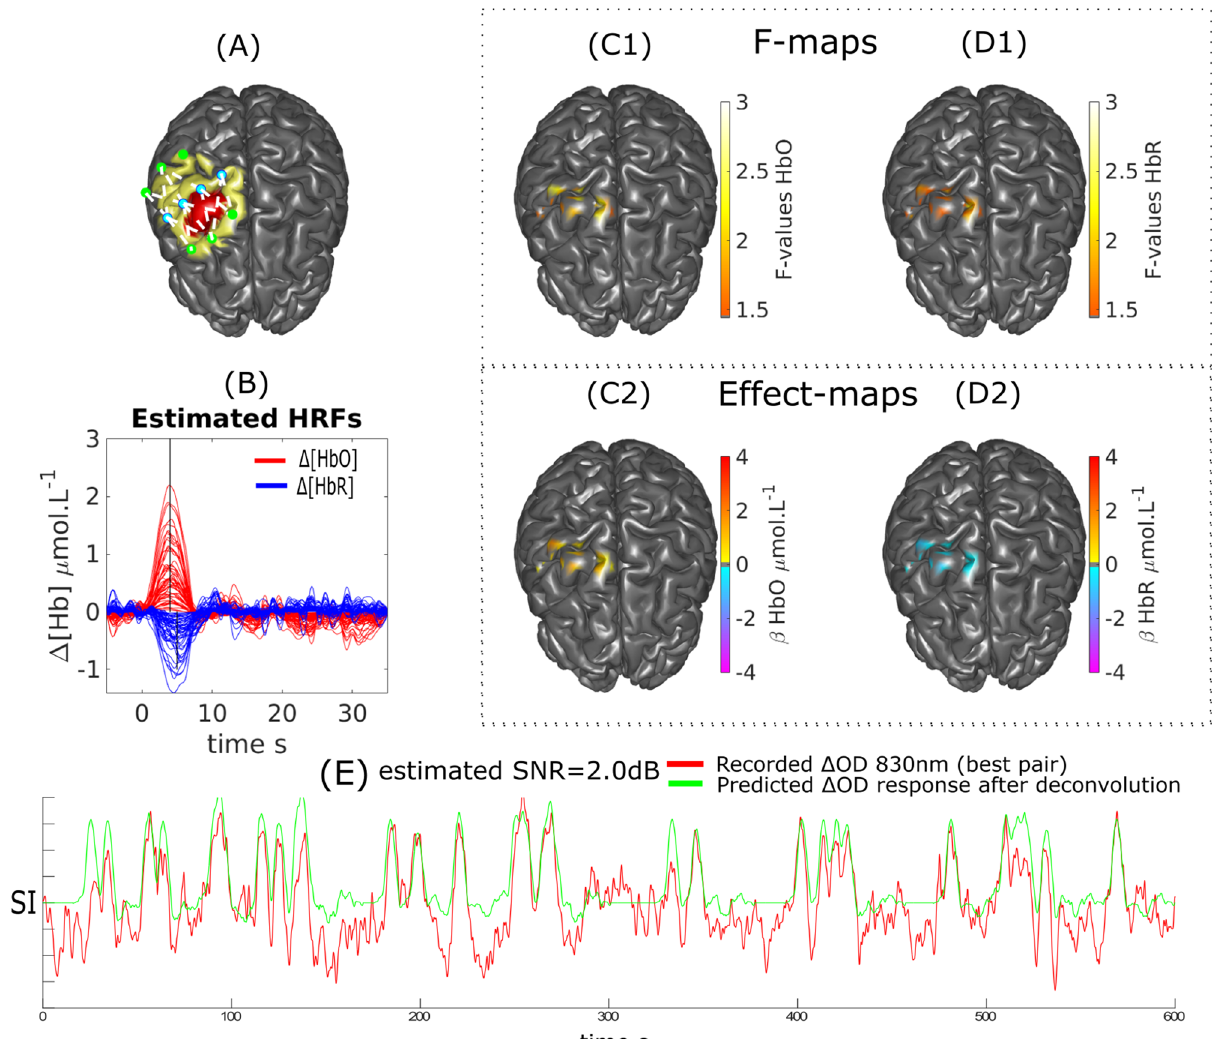
Figure 10. DOT reconstruction and HRF deconvolution for a finger opposition task on Subject 2. ( A ) Montage, ROI (red) and FOV (yellow). ( B ) Estimated HRF time courses. ( C1 , C2 ) (cid:31) [ HbO ] : Thresholded F-map ( α = 0.05 , Bonferronni corrected) and associated effect size map estimated at TTP 1 = 5 s. ( D1 , D2 ) (cid:31) [ HbR ] : Thresholded F-map ( α = 0.05 , Bonferronni corrected) and associated effect size map estimated at TTP 1 = 6 s. 830 ( E ) Most sensitive (cid:31) OD pair over the target ROI and corresponding predicted response after deconvolution (at the sensor level) with the binary stimuli